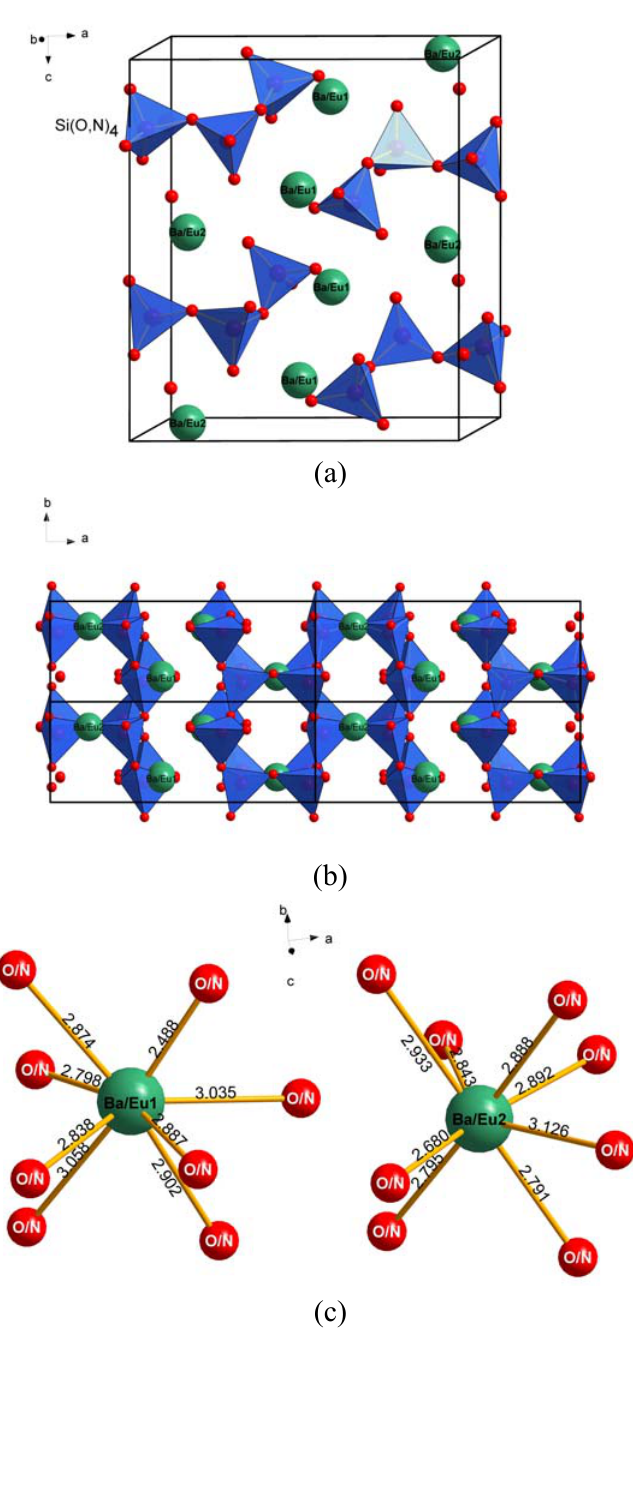
Figure 5. Projection of the crystal structure of Ba along (a) (010), (b) (001), and (c) the local coordination of the Ba/Eu atoms with O/N atoms. The large green sphere represents Ba/Eu atoms and small red sphere represents O/N